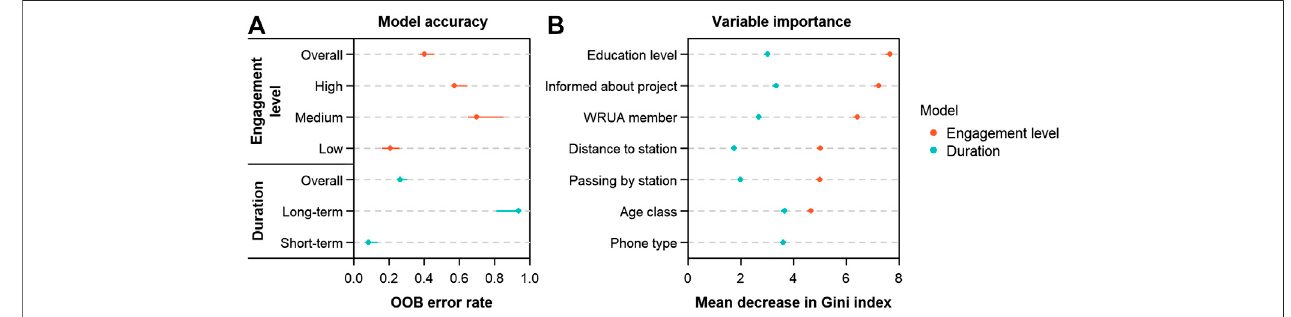
FIGURE 6 | Performance of the random forest models to predict the level and duration of engagement of the participants in the citizen science water monitoring project: (A) model accuracy based on out-of-bag (OOB) error rate and (B) relative importance of the included variables in each model. The circles indicate the median value, the segments indicate the range of values across 10,000